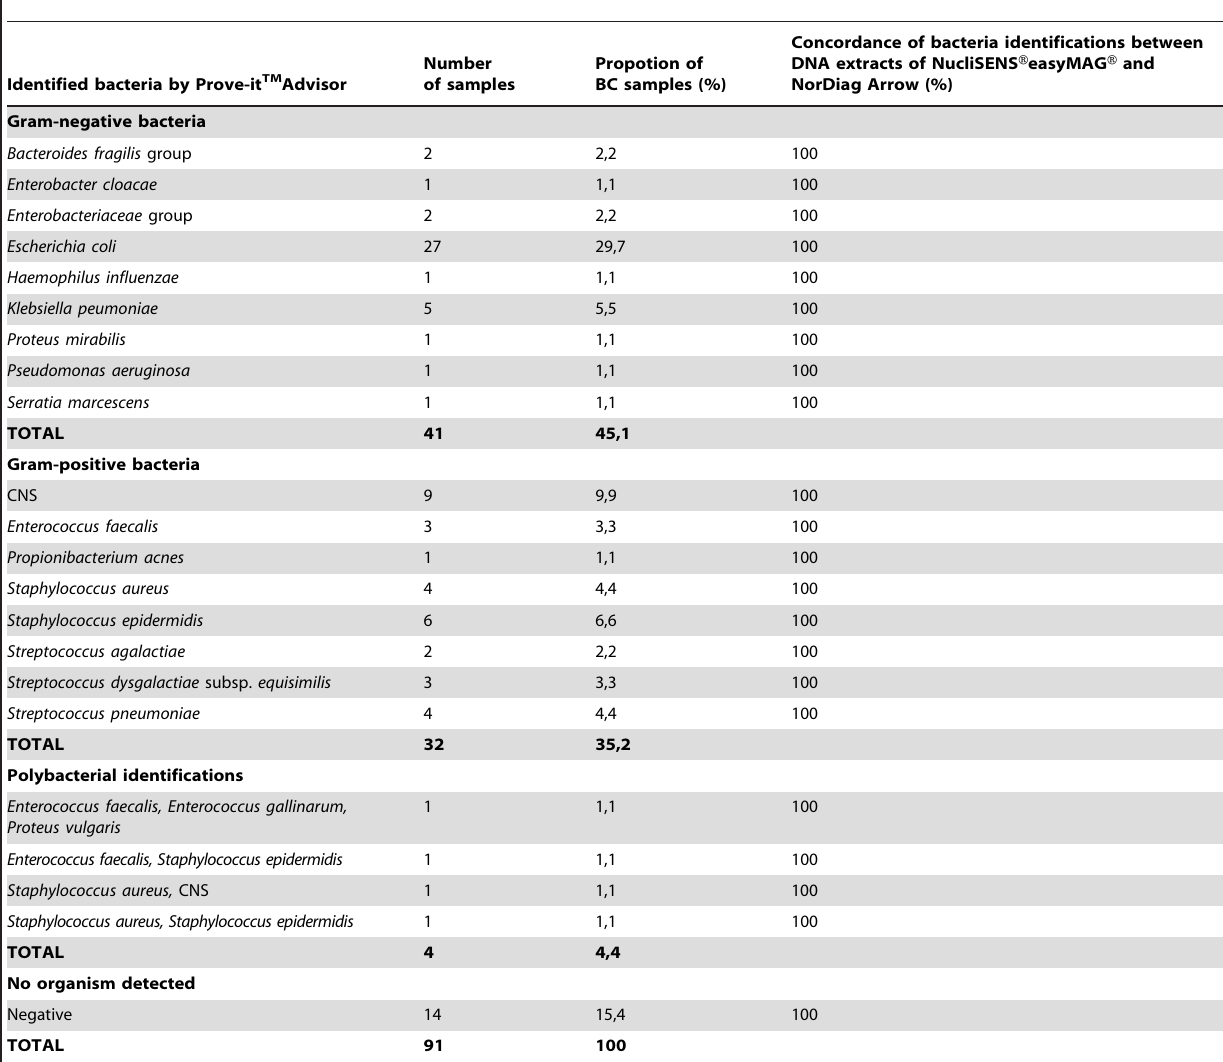
Table 1. Comparison of identifications of various agents identified from the blood culture (BC) samples with respect to the used DNA extraction solutions of NucliSENS H easyMAG H and NorDiag